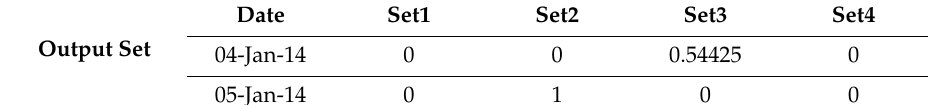
Table 7. 04-Jan-14 Output Set.